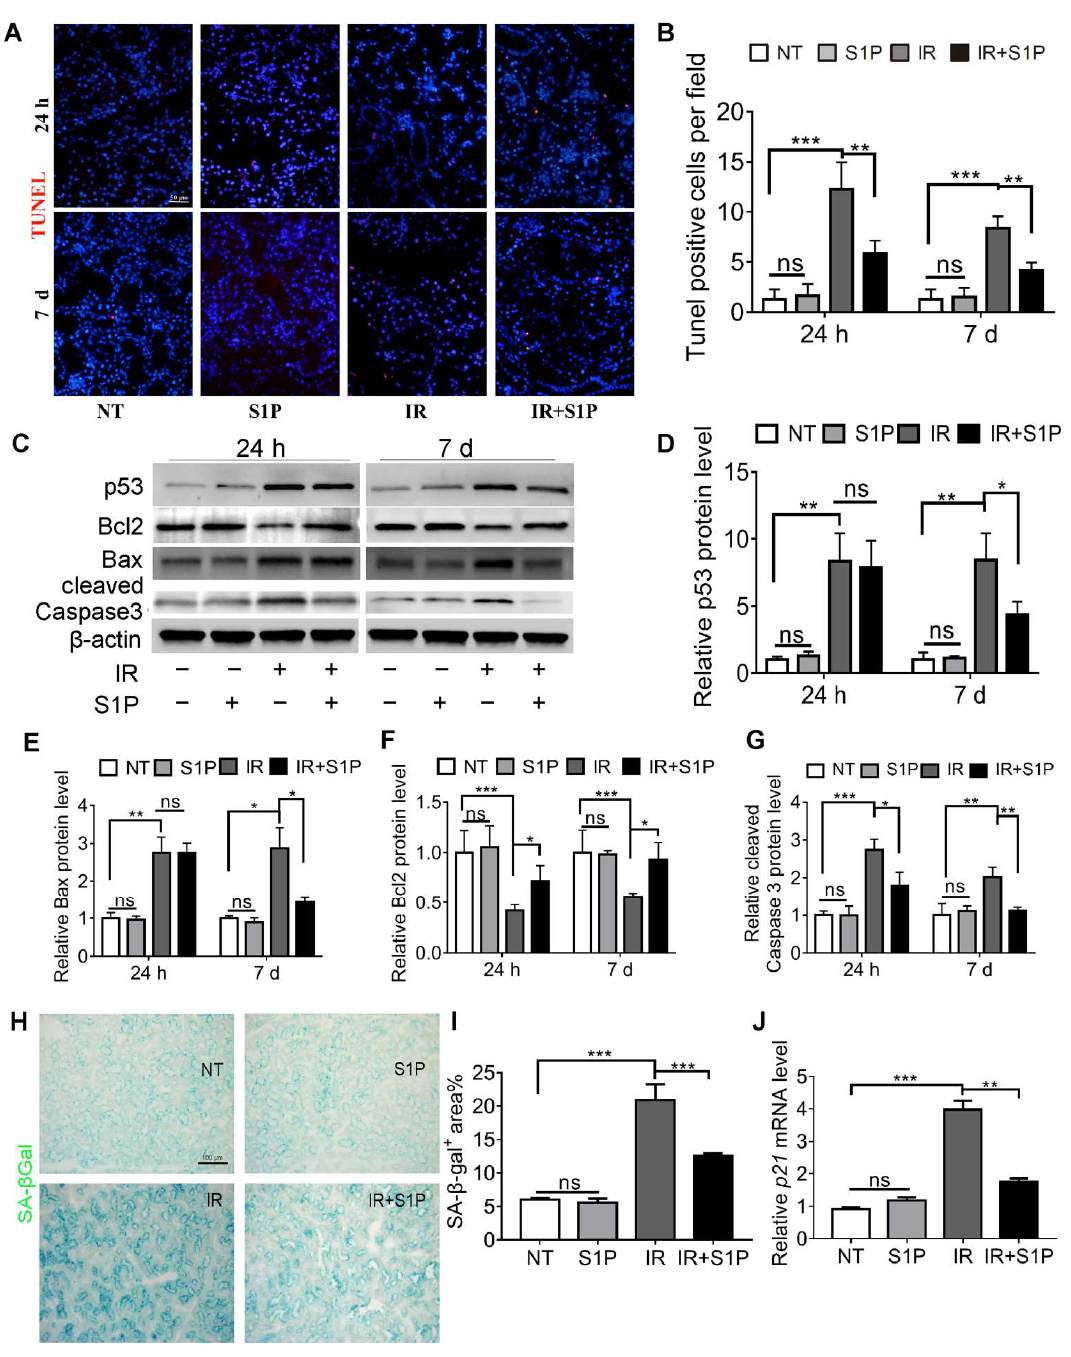
Figure 2. S1P decreased apoptosis and cellular senescence in radiated salivary glands. ( A , B ) TUNEL staining of SMG frozen sections collected 24 h or 7 days after IR or S1P treatment. Magnification: × 400. ( C – G ) Western blot analyses of Bax, Bcl 2, p53, and cleaved Caspase 3 proteins. ( H , I ) Senescence-associated β -galactosidase (SA- β -Gal) staining and semiquantitative analysis of SA- β -Gal-positive areas. ( J ) RT-qPCR analysis of mRNA levels of p21 . Data are shown as mean ± SD, N = 3, *: p < 0.05, **: p < 0.01, ***: p < 0.001, ns: not significant. Quantitative data were analyzed using one-way ANOVA with Tukey’s multiple